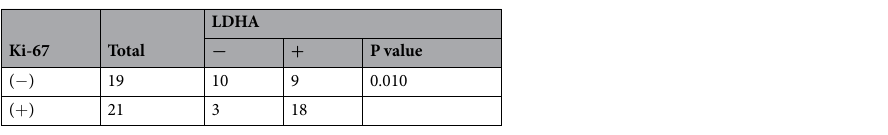
Table 1. The relationship between LDHA and Ki-67 index in pituitary adenomas (n = 40). The immunostaining score of LDHA was scored as negative ( − ) to indicate staining score with less than 30, positive ( + ) to indicate score with more than